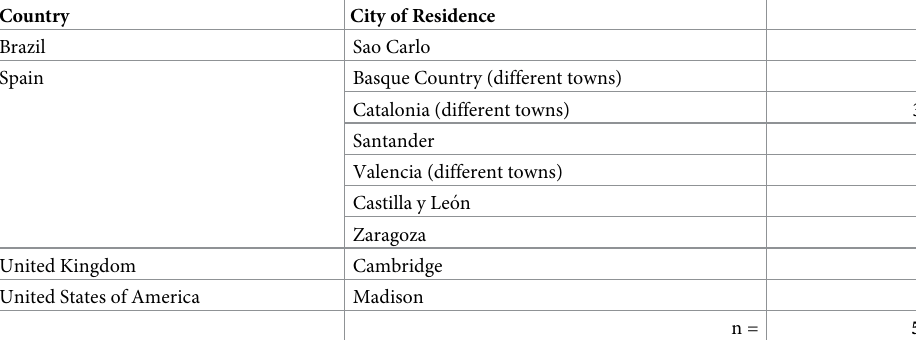
Table 3. Country and place of residence of